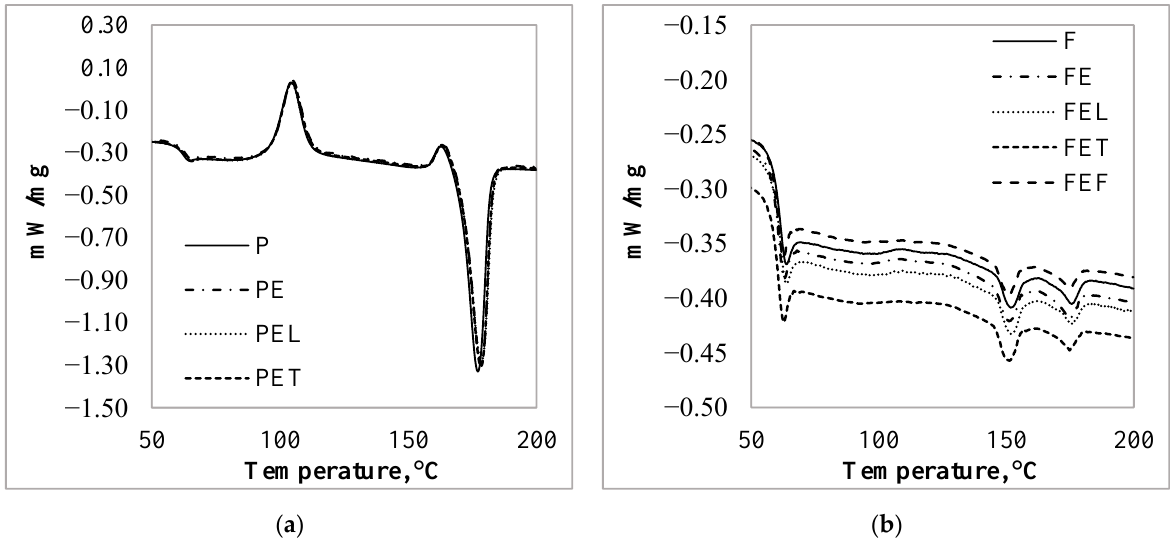
Figure 8. PLA microparticles second heating DSC curves after the adsorption measurement: ( a ) 3D850 granules; ( b ) 4043D granules.